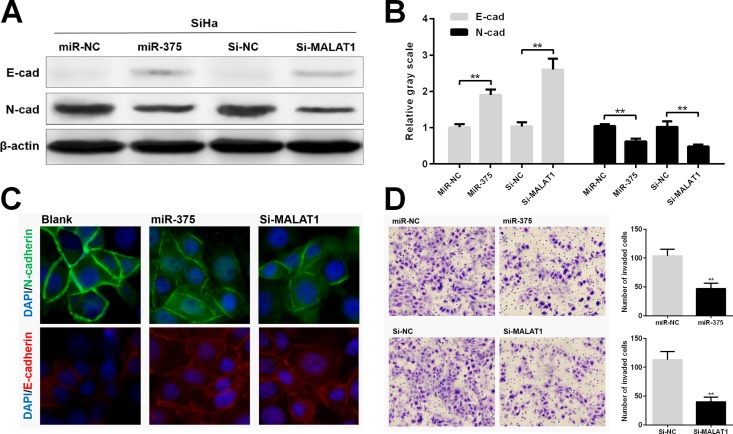
MiR-375 can suppress EMT of cervical cancer cells partly via downregulating MALAT1.A-B. Western blot analysis images (A) and quantitation of relative gray scale (B) of E-cadherin (E-cad) and N-cadherin (N-cad) in SiHa cells transfected with miR-375 mimics or MALAT1 siRNA. C. Immunofluorescent staining of E-cadherin and N-cadherin in SiHa cells transfected with miR-375 mimics or MALAT1 siRNA (red: E-cadherin, green: N-cadherin, Blue: DAPI). D. Representative images and quantitation of invaded SiHa cells after transfection of miR-375 mimics or MALAT1 siRNA by transwell assay. ** p<0.01.